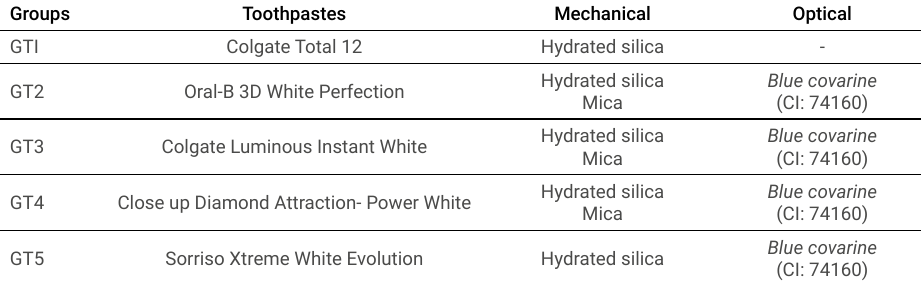
Table 2. Principal whitening agents present in the toothpastes tested.